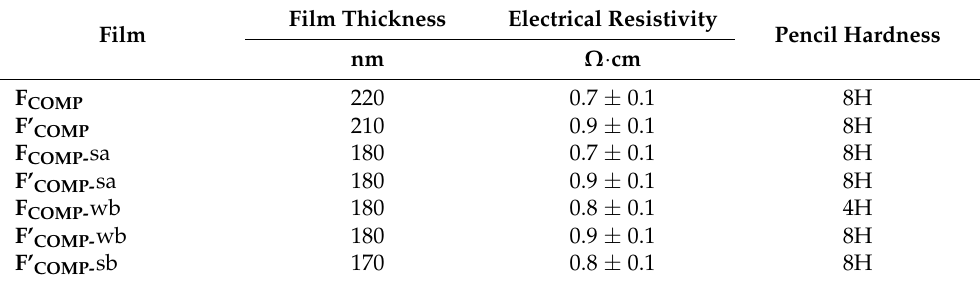
Table 1. Film thicknesses, electrical resistivities, and pencil hardnesses of F COMP and F’ COMP fabricated onto the quartz glass substrate, along with those of the chemically treated thin films F COMP-